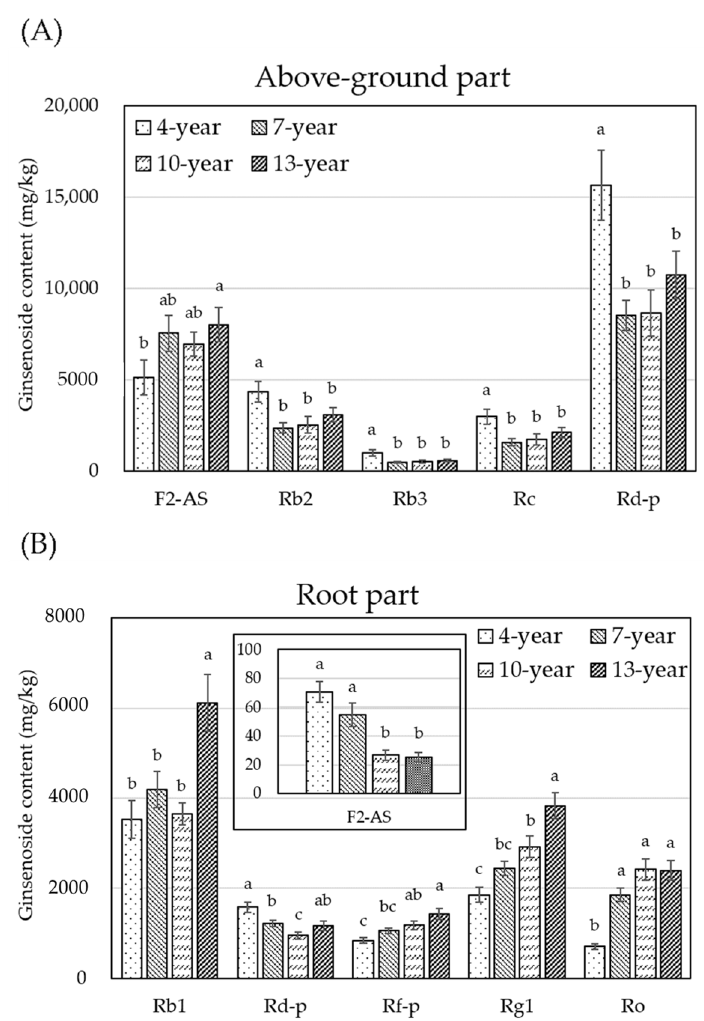
Figure 4. Ginsenoside contents of wild-simulated ginseng with different cultivation periods. ( A ) Above-ground part, ( B ) Root part. Value in each column with different letters are statistically dif- ferences ( p < 0.05) among the treatments according to Tukey’s test (n = 25).